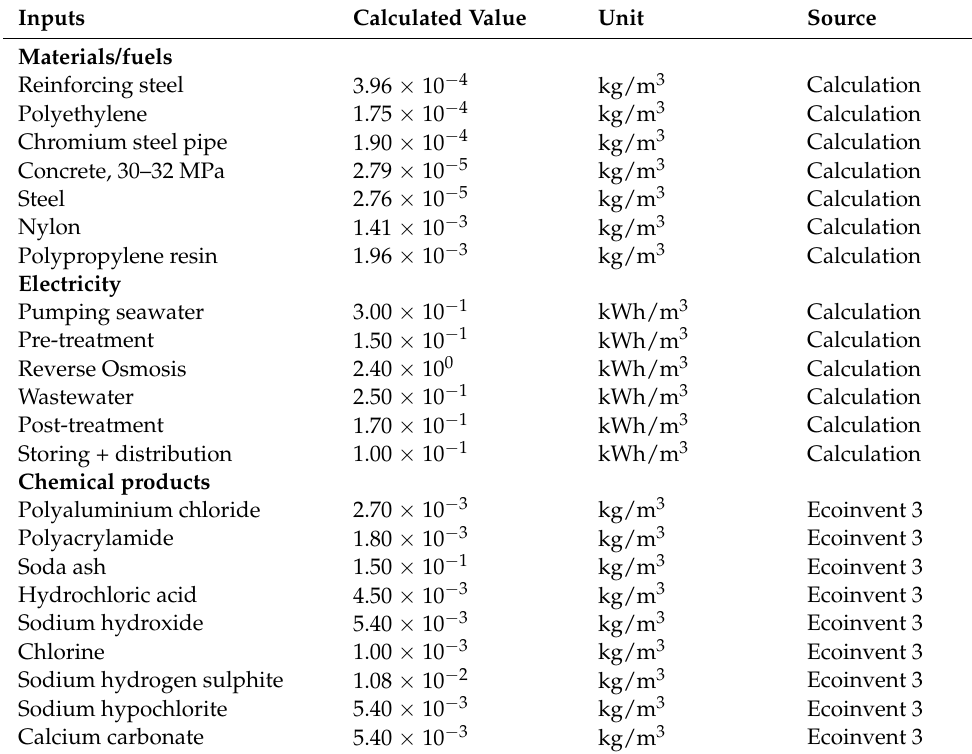
Table 1. The spreadsheet of inventory data of 1 m 3 of desalinated water production.